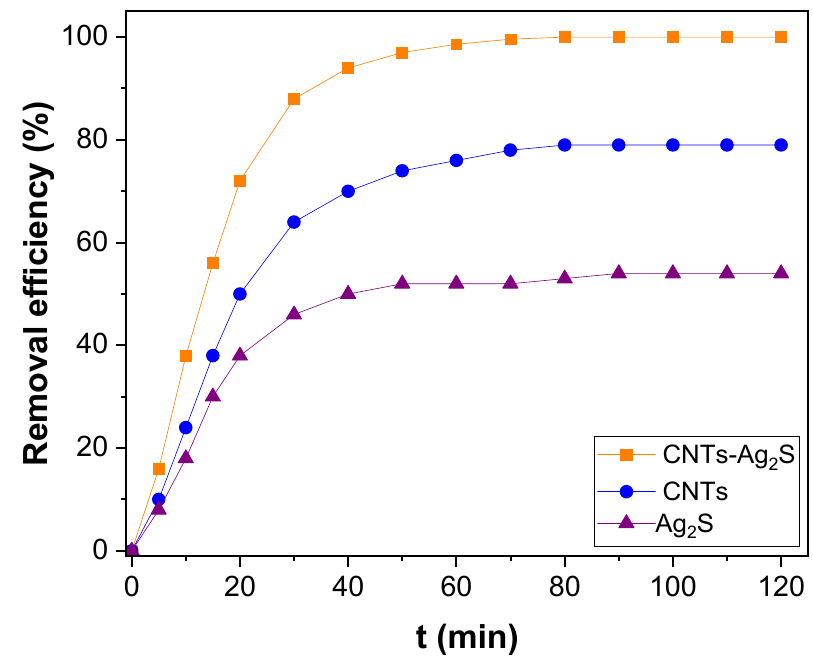
Figure 7. Adsorption kinetics of Cd(II) over CNTs, Ag 2 S, and CNTs-Ag 2 S. The pseudo-first-order plot obtained for Cd(II) adsorption over CNTs, Ag 2 S, and CNTs-Ag 2 S is shown in Figure 8. The correlation coefficients (R 2 ) perceived for CNTs, Ag 2 S, and CNTs ‐ Ag 2 S were 0.9906, 0.9540, and 0.9930, respectively. The k 1 and q e were computed using the slope and intercept values of the straight lines acquired in Figure 8. The estimated values of k 1 and q e is summarized in Table 1. The calculated q e (cal) could not agree with the experimental value q e (exp) for all samples. Thus, the experimental data